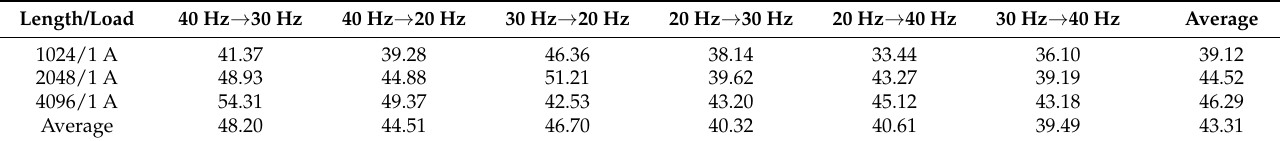
Table 7. Rotating speed adaptability test results.